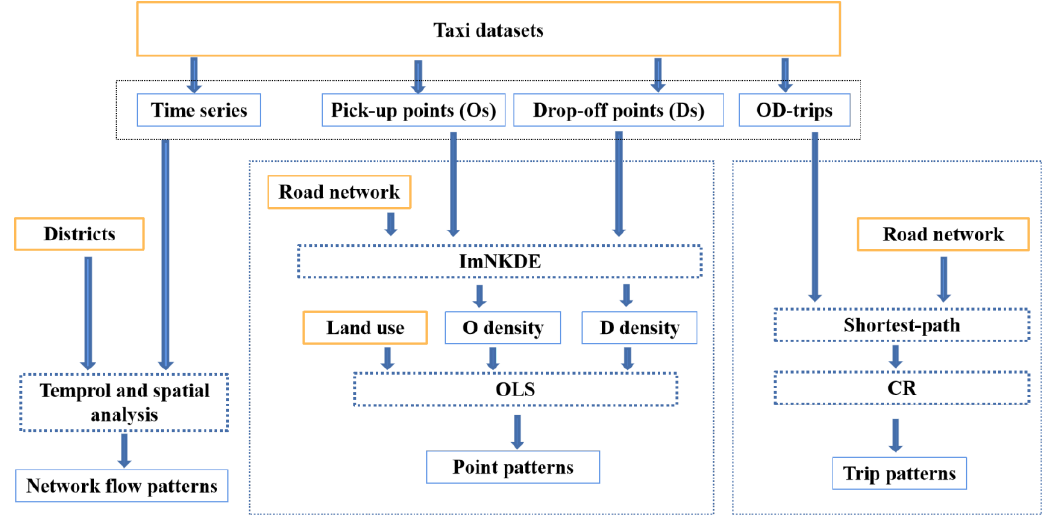
Figure 5. The workflow for discovering spatial-temporal patterns.